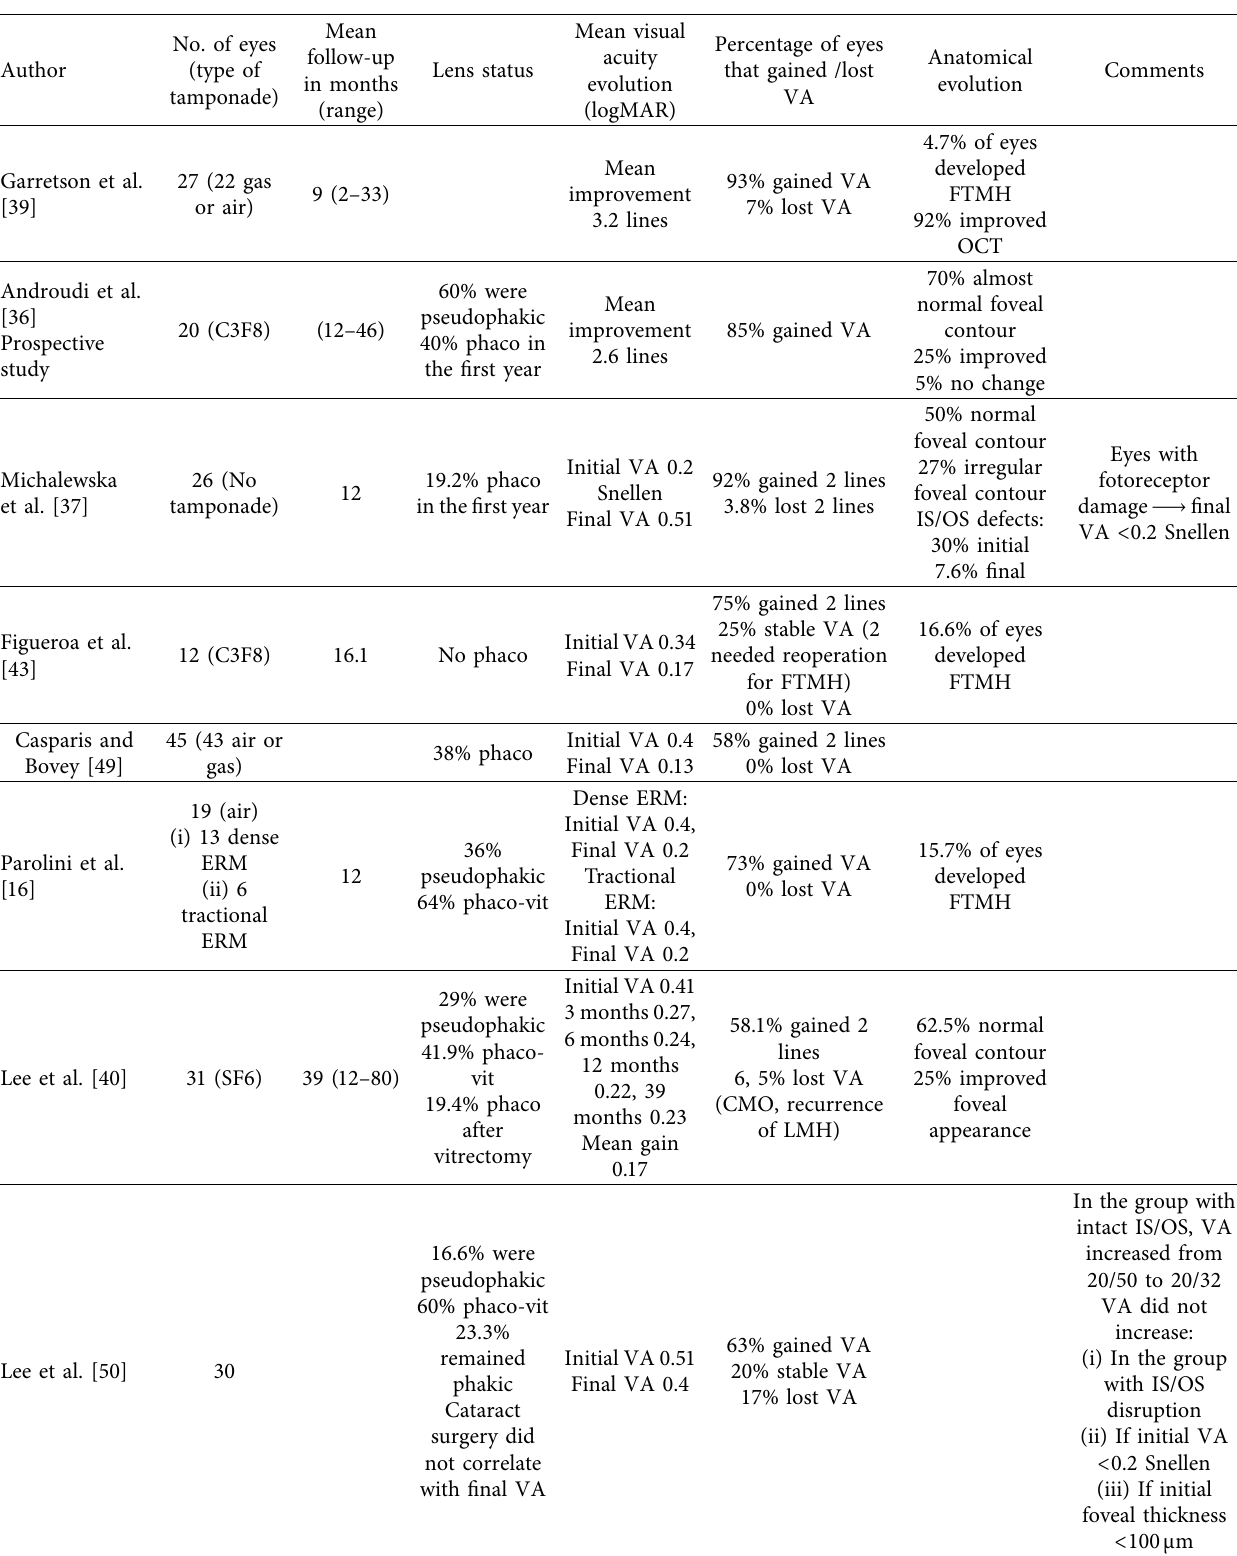
Table 2: Interventional